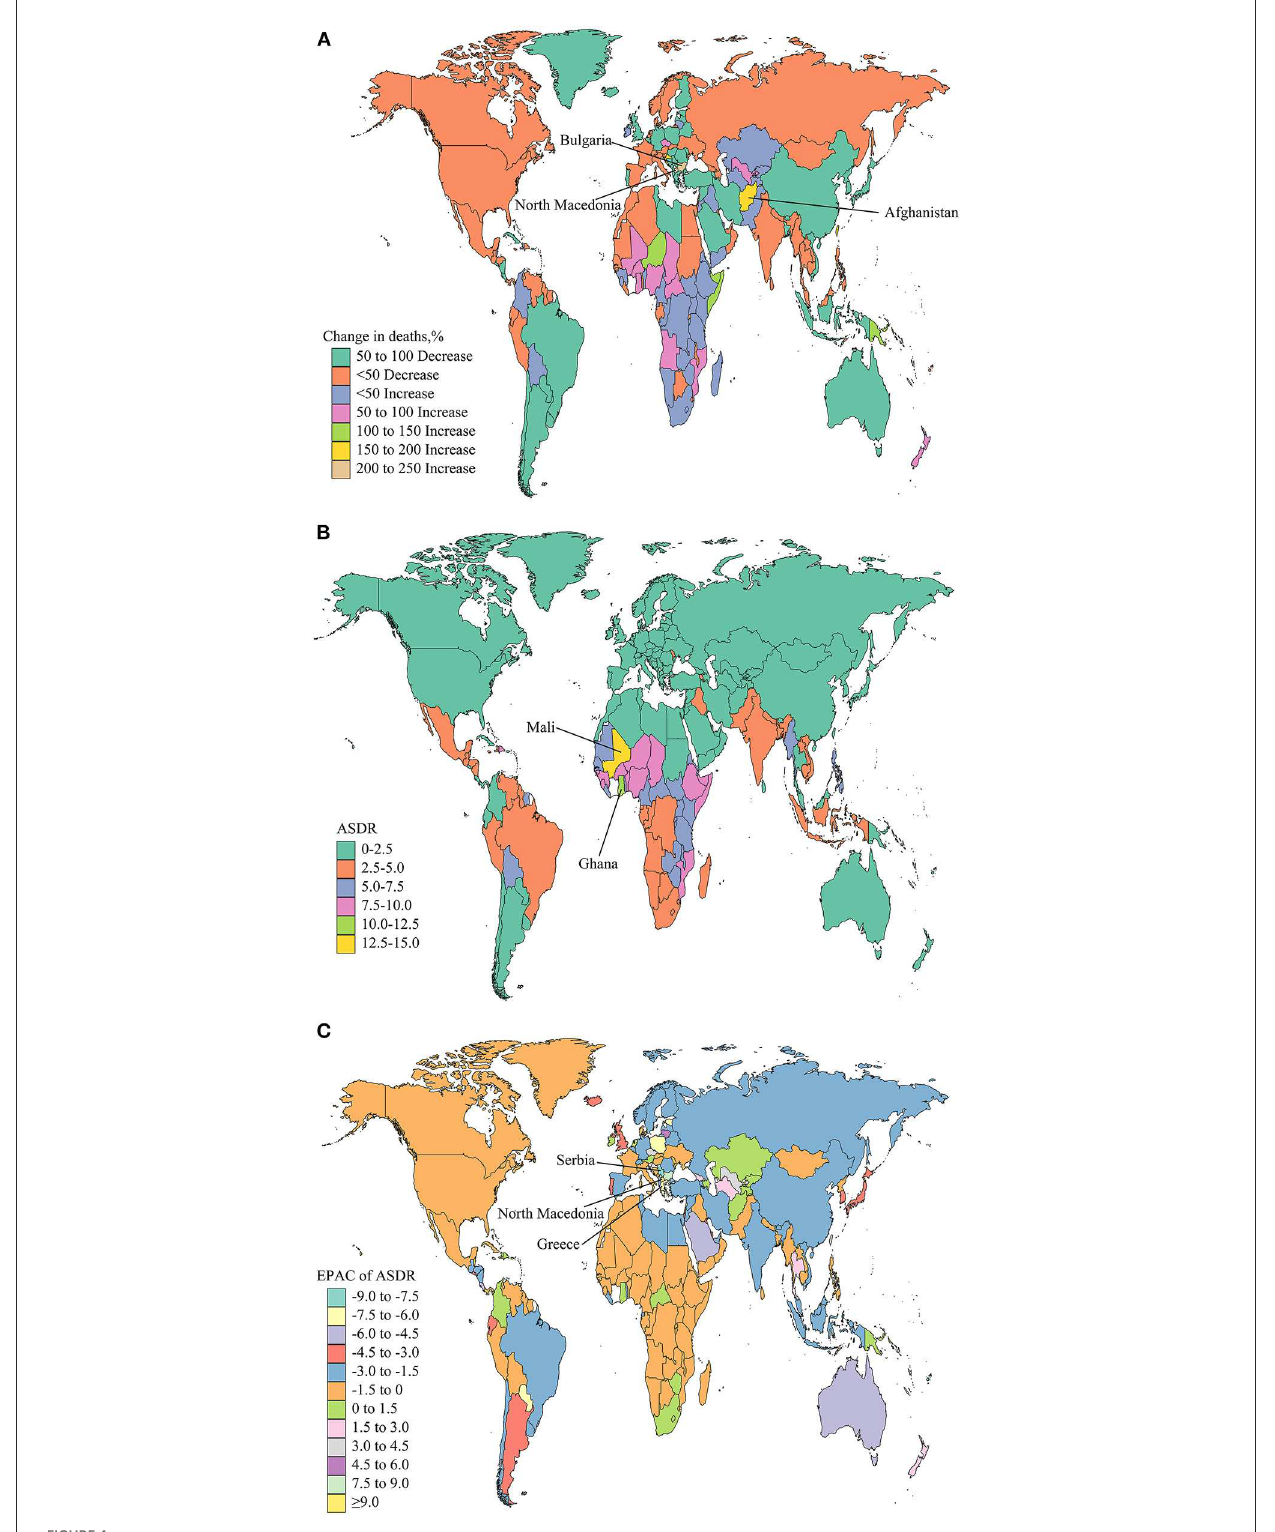
FIGURE4 Global trends in the deaths of NSNIs in 204 countries and territories. The percentage of relative change in deaths of NSNIs between 1990 and 2019 (A) , age-standardized deaths rates (ASDRs) of NSNIs in 2019 (B) , and estimated annual percentage changes (EAPCs) of ASDRs of NSNIs from 1990 to 2019 (C) were